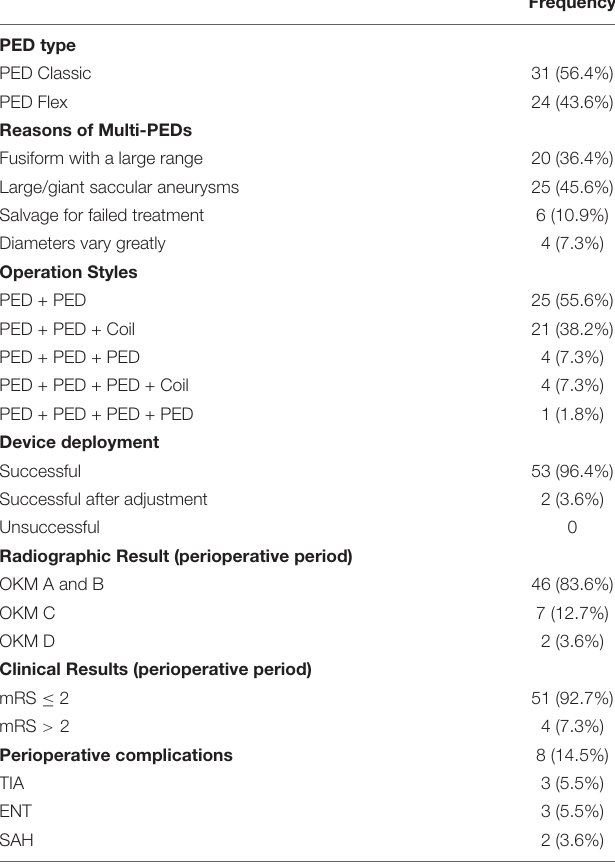
TABLE 2 | Treatment details and results.